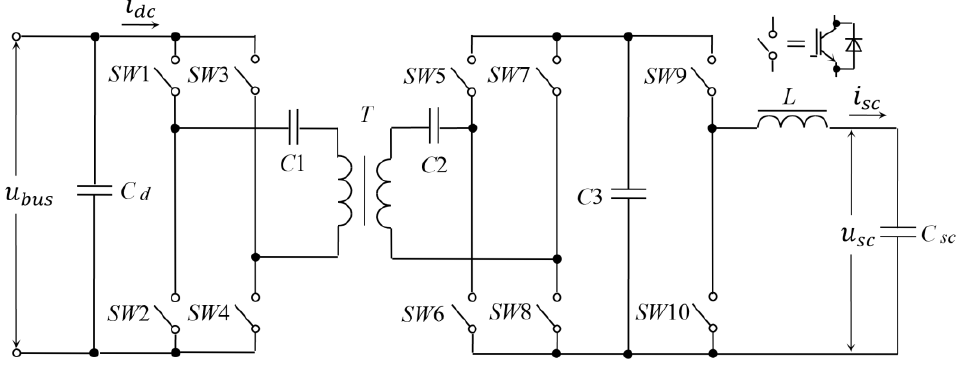
Figure 17. Full bridge resonant DC/DC converter topologies.